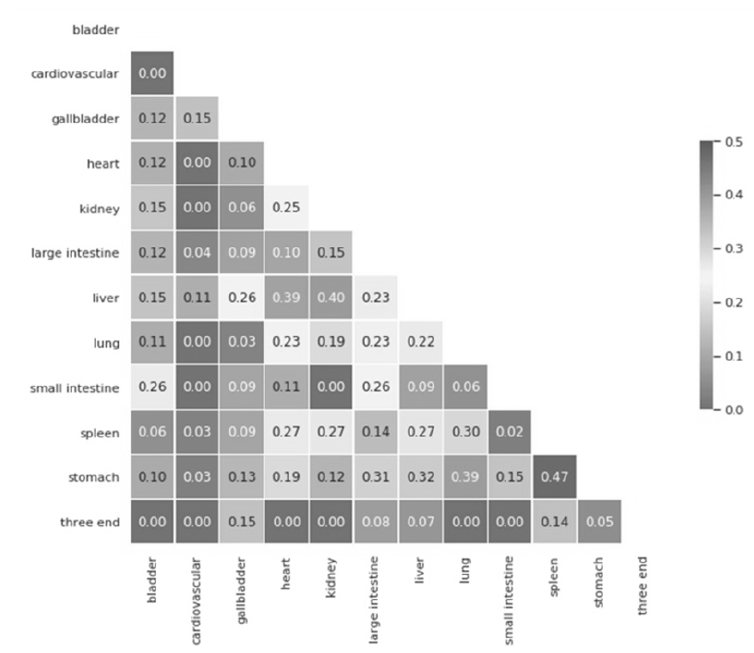
Figure 3. Cosine similarity among Meridians.